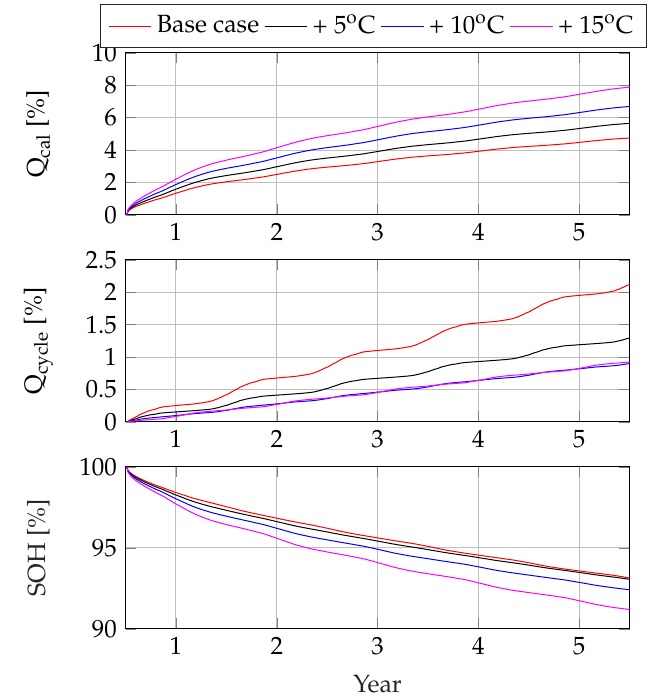
Figure 12. Comparison between the JP base case with SOC equal to 55% and the cases with outside temperature increase of 5, 10 and 15 ◦ C: subplot 1 calendar degradation, subplot 2 cycle degradation and subplot 3